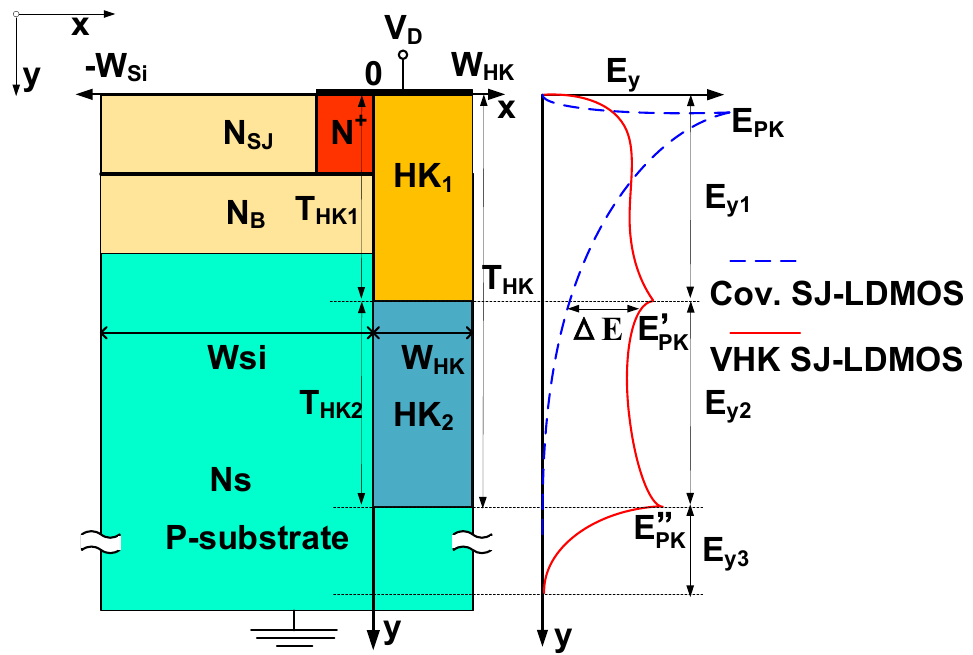
Figure 2 shows the schematic cross-section view and E-field component profiles of VHK SJ-LDMOS. In the off-state, the composite layer of HK and semiconductor under the drain jointly sustains the vertical bias voltage (V R ) of the VHK SJ-LDMOS, which can be qualitatively considered as a semiconductor with an equivalent permittivity of ( ε Si + ε HK ). The Variable-K pillar beside the substrate, the drain electrode/VHK/oxide/Si structure can be treated as a metal-insulator-semiconductor (MIS) capacitance [14,15], which makes it easier to deplete a higher N S (allowing for a lower resistivity substrate) and a higher N B by the assisted depletion effect to decrease R ON,sp .